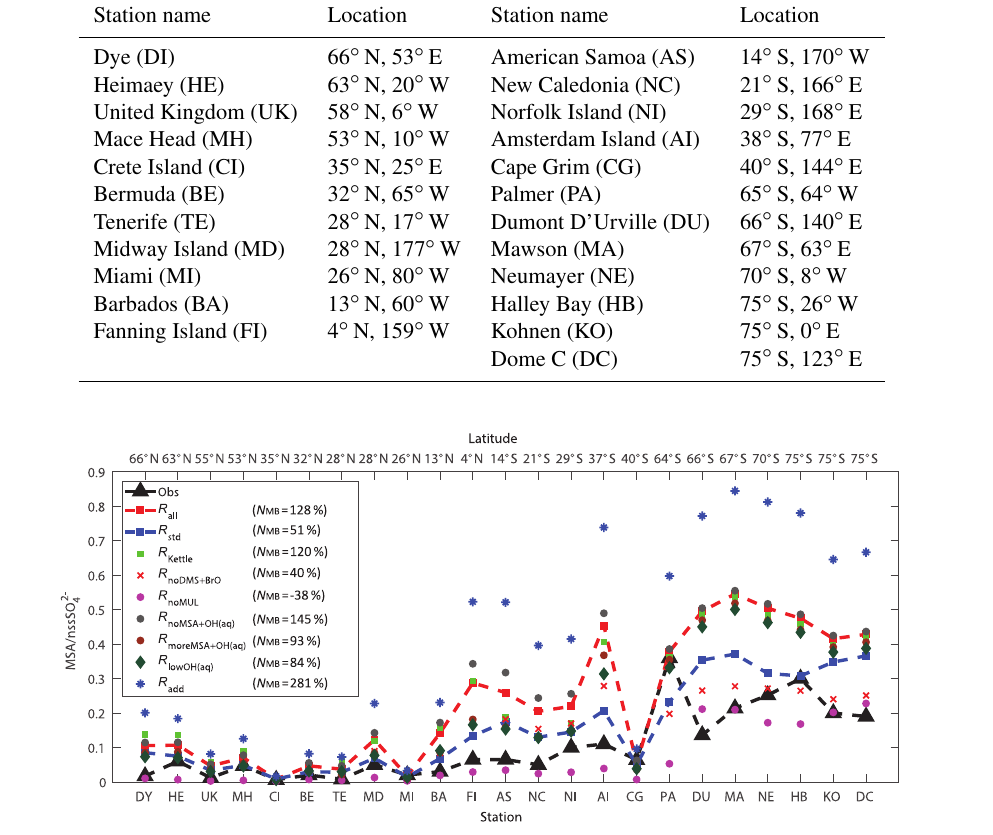
23 P (M i − O i ) i = 1 × 100%, where M i and O i are 23 P O i i = 1